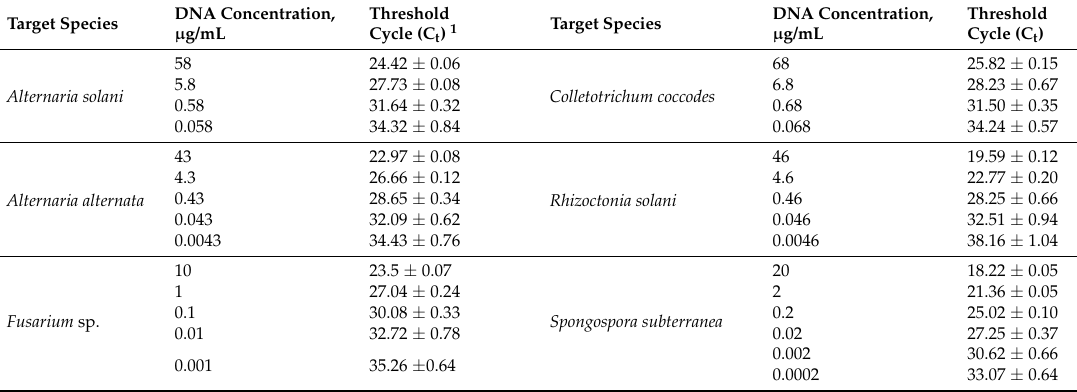
Table 4. Performance of the diagnostic systems for serial dilutions of DNA of target species.